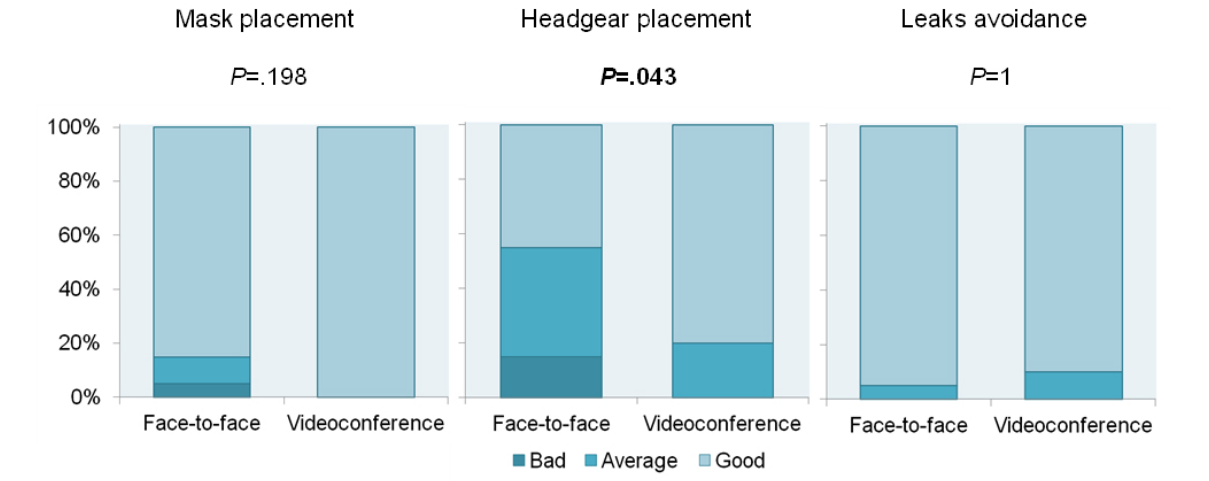
Figure 3. Results distribution of the practical evaluation of patients’skills on placing the mask, the headgear, and avoiding leaks from the mask (study 2). A blinded expert scored patients’performance on a ascendant scale: 0 (bad), 1 (average), and 2